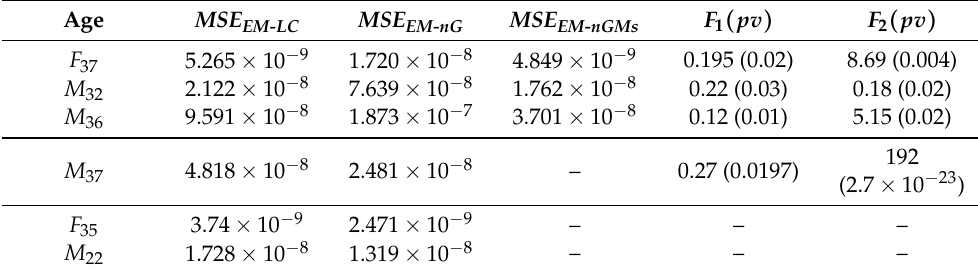
Figure 7. The values of mortality rates—male, age 22: empirical (Emp), theoretical (LC, nGs), forecasts (nGsf), and c. interval based on the LC, and nGs model with switch. Table 1. MSE (goodness of fit), F-statistics, p -value ( pv )).